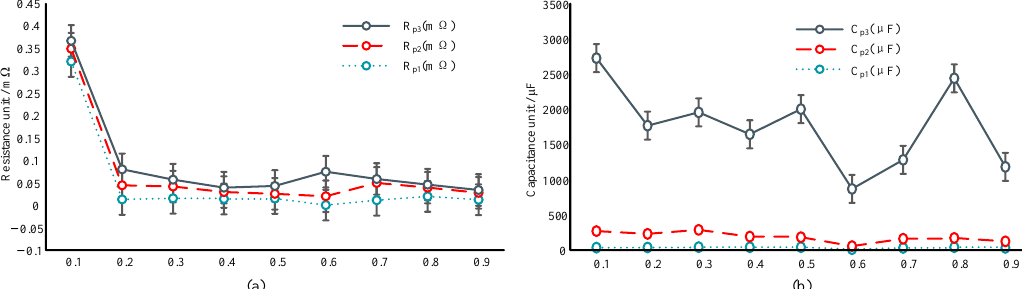
Figure 3. Polarization resistance and capacitance of RC link under the third order Thevenin model.